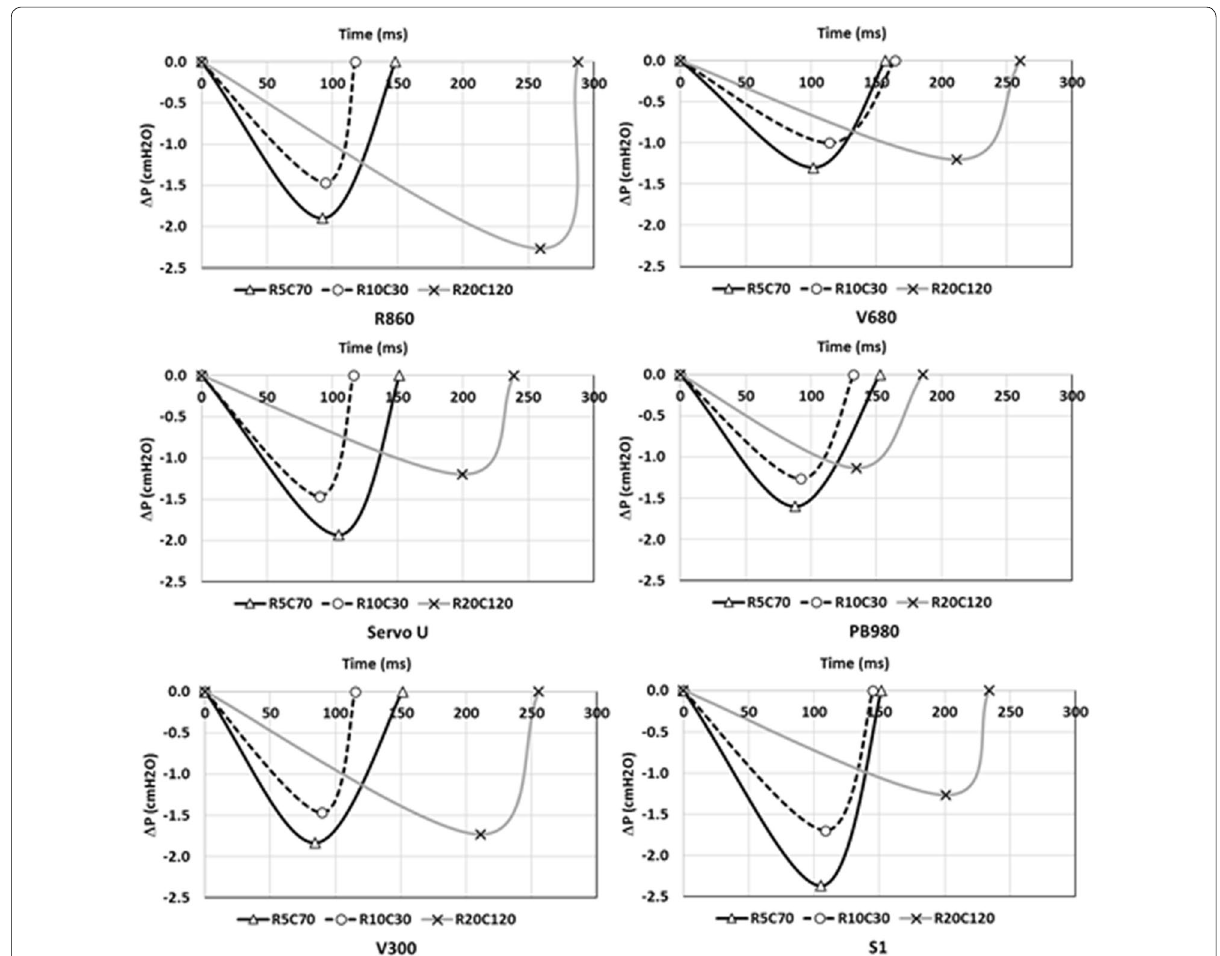
Fig. 3 Triggering evaluation according to respiratory mechanics combinations. R: resistance; C: compliance; ΔP: maximal pressure drop required to trigger inspiration; DT: triggering delay, from the onset of the airway pressure decay (beginning of the patient’s effort) to flow delivery (begin- ning of ventilator pressurization); DP: pressurization delay, from the airway pressure signal rise to a return to positive pressure; DI: overall inspiratory delay (DT DP). Triangle and black line : results for the ‘Normal’ respiratory mechanics; circle and dotted line : results for the ‘Restrictive’ respira- + tory mechanics; cross and grey line : results for the ‘Obstructive’ respiratory mechanics ( Normal : resistance [ R ] [ C ] tory effort initiation; second point represents maximal depressurization (ΔP) before inspiratory pressure increase. There was no significant difference in terms of DT and DI between ventilators, nor in terms of maximal depressurization (ΔP). DI variability according to respiratory mechanics was higher for V500 and